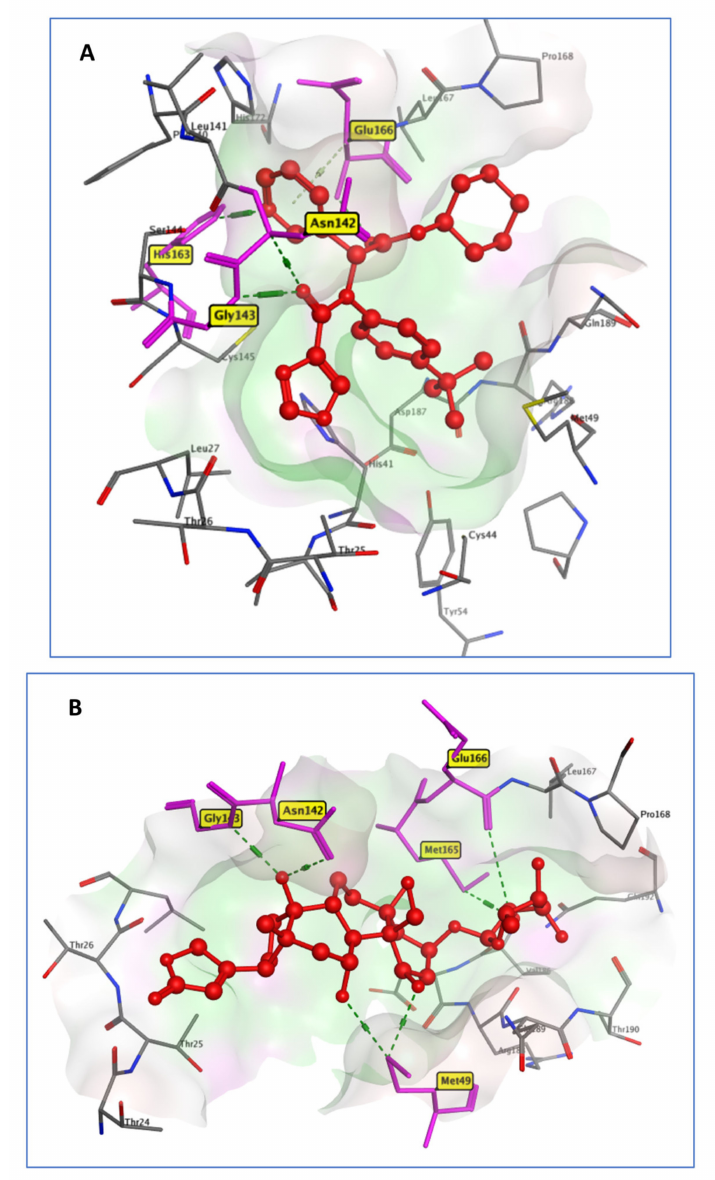
Figure 3. 3D model of the interactions of cocrystallized ligand X77 ( A ) and OUB ( B ) with Mpro active site